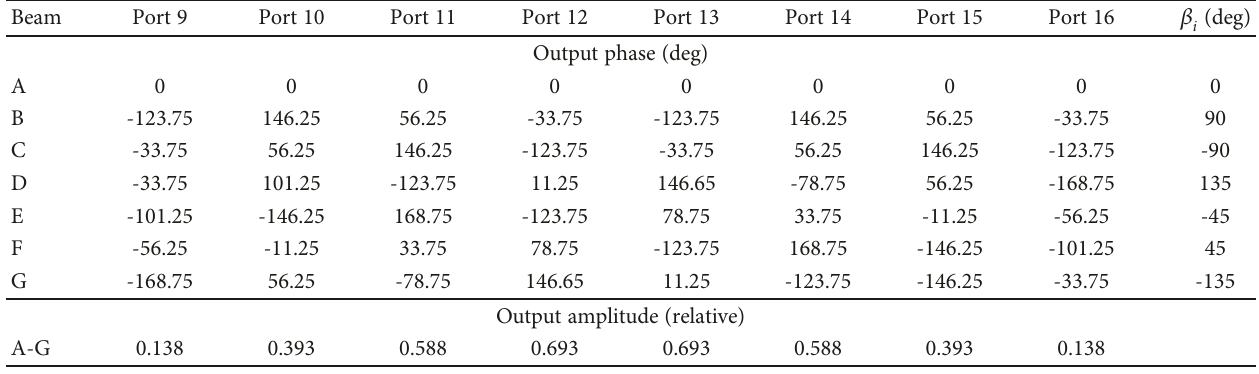
× 8 BM for the excitation shown in Table 4. i of the 8